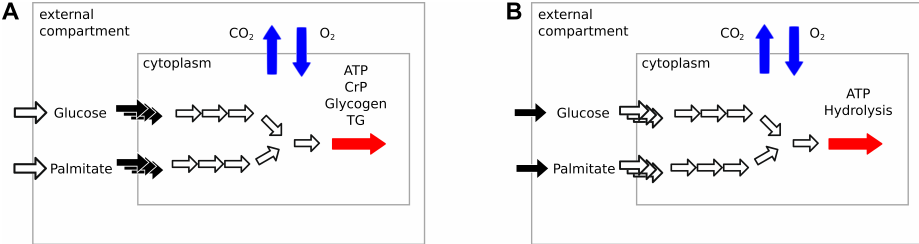
Figure 1. Simplified representation of two different descriptions of the fast to fed transition in a constraint-based metabolic model. ( A ) Architecture of the simulation presented in [11]: change in nutrient availability during the fast to fed transition is modeled by modulating the flux through glucose and palmitate transporters, the reactions transporting substrates between the external and the cytoplasm compartments (black arrows). Production of ATP, creatinine phosphate (CrP), glycogen and triglycerides (TG) was used as objective reaction (red arrow). The availability of glucose and palmitate in the external compartment is assumed to be infinite. ( B ) Architecture of the simulation presented in this study. The fast to fed transition is modeled by modulating the amount of nutrients available in the external compartment through exchange reactions (black arrows). ATP phosphodi- ester bond hydrolysis (ATPH) is used as objective function (red arrow). The models are free to choose the optimal mix of substrates to optimize the flux through the objective function. RQ is defined as the ratio between CO 2 efflux and O 2 influx (blue arrows) in both implementations. Blank arrows represent reactions that were left